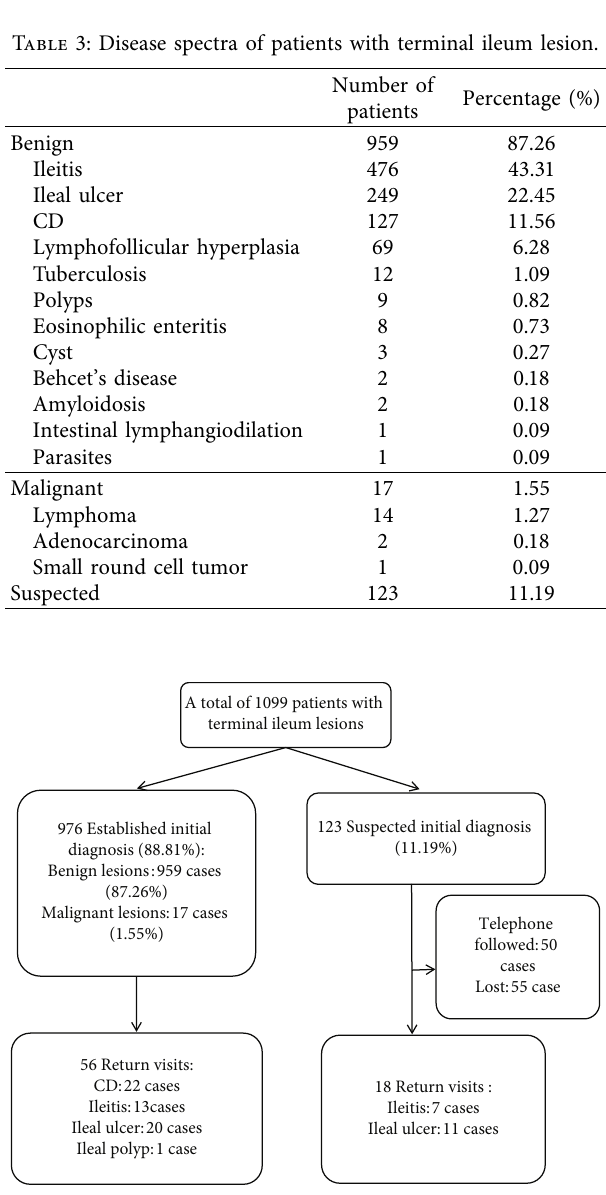
Figure 1: Flow chart of patients with terminal ileum